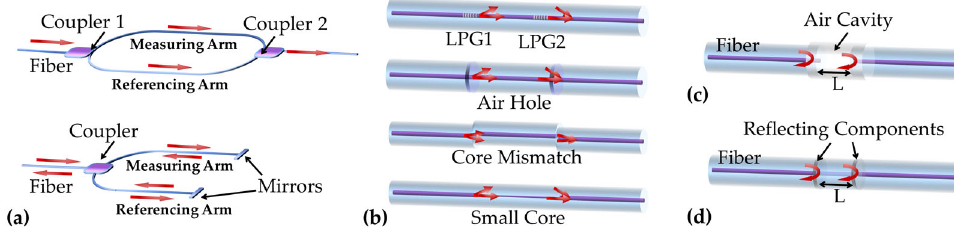
Figure 2. ( a ) Configurations of typical optical fiber MZI; ( b ) configurations of various types of in ‐ line optical fiber MZIs. ( b ) Configuration of extrinsic ( c ) and intrinsic ( d ) FPI based on optical